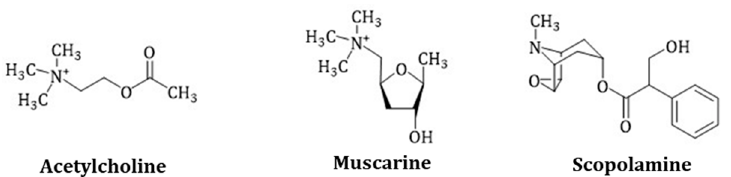
Figure 2. Comparison of the chemical structures of acetylcholine, muscarine and scopolamine. Scopolamine is protonated in the body due to the physiological pH and is present as a quaternary ammonium salt.